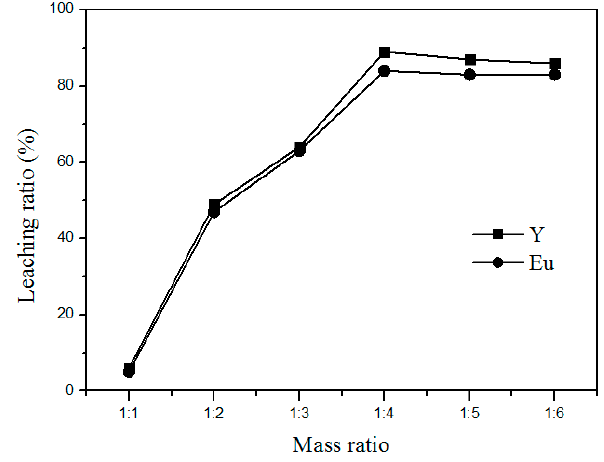
Figure 6. Effect of NH 4 Cl addition on the leaching rate of Y and Eu.